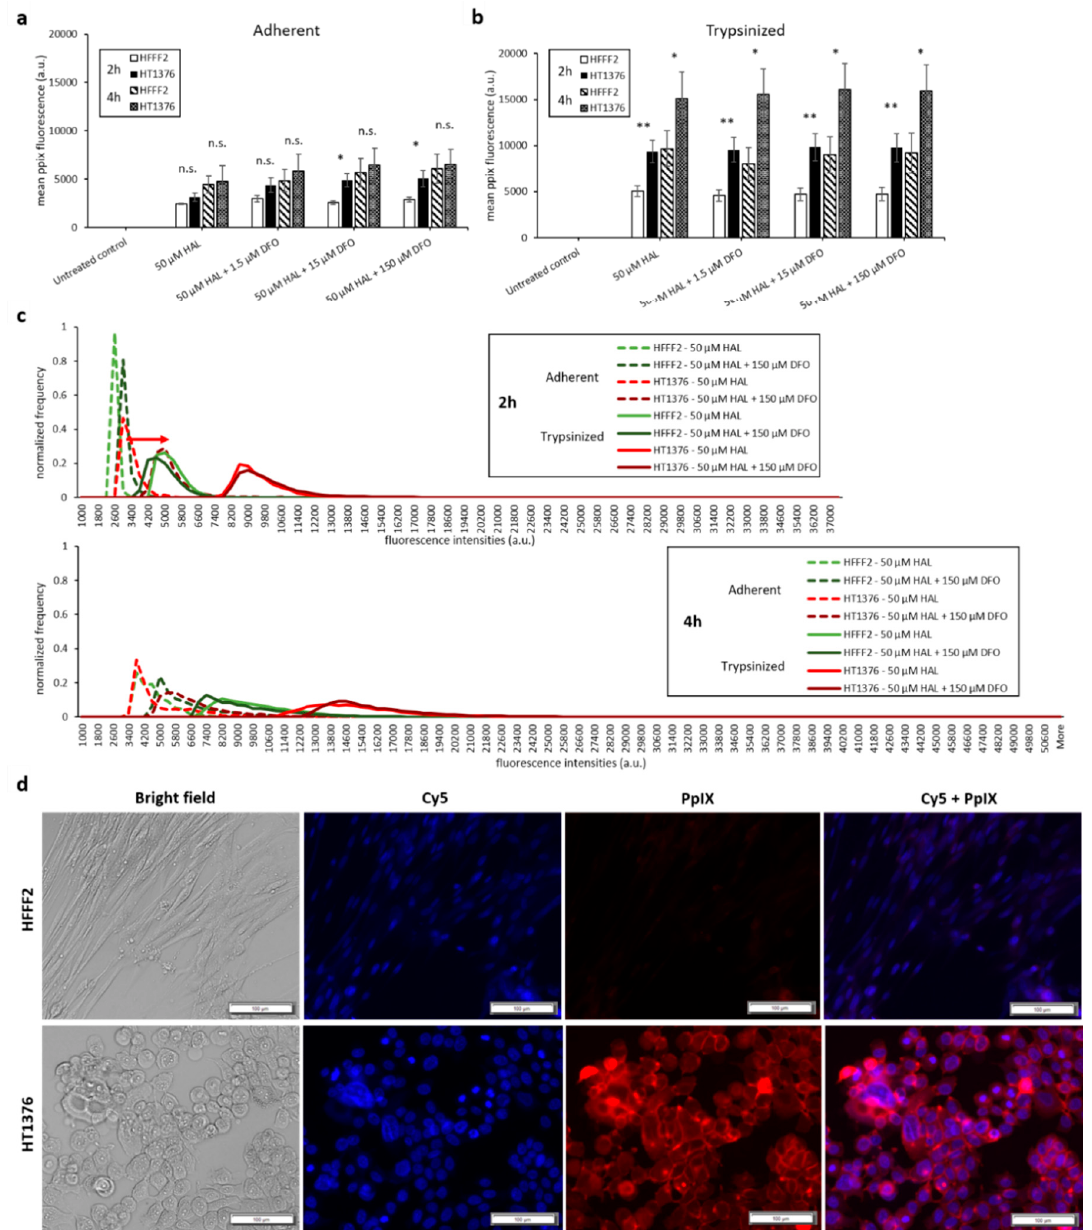
Figure 5. E ff ect of DFO and HAL treatment on PpIX fluorescence in human bladder cancer HT1376 and human fibroblast HFFF2 cells. Cells were incubated with HAL (50 µ M) alone or HAL (50 µ M) and di ff erent concentrations of DFO (1.5 to 150 µ M) in PBS for 2 and 4 h. Mean ± SD ( n = 3), statistical significance by ANOVA. n.s. = not significant, * p < 0.05 and ** p < 0.01, compared between bladder cancer HT1376 and human fibroblast HFFF2 cells in the same conditions. PpIX fluorescence was measured in adherent and trypsinised cells. Results are expressed in ( a and b ) bar and ( c ) histogram (50 µ M HAL + 1.5 / 15 µ M DFO not shown) graphs. ( d ) Microscopic images showing the PpIX fluorescence in adherent bladder cancer HT1376 cells after combined treatment with HAL and 150 µ M DFO compared to fibroblast HFFF2 cells (trypsinised cells images not shown). Scale bars represent 100 µ m, magnification is 10X.